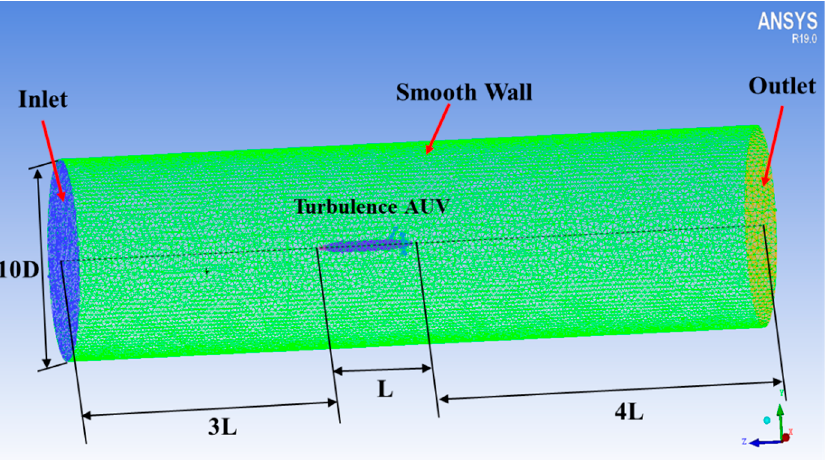
Figure 3. The computational domain and unstructured tetrahedron grid of the turbulence AUV. L is the length of the turbulence AUV and D is the diameter. The computational domain is set to be cylindrical with a diameter of 10 D, the inlet boundary is located at the 3 L head of the turbulence AUV, and the pressure outlet condition is installed 4 L downstream.